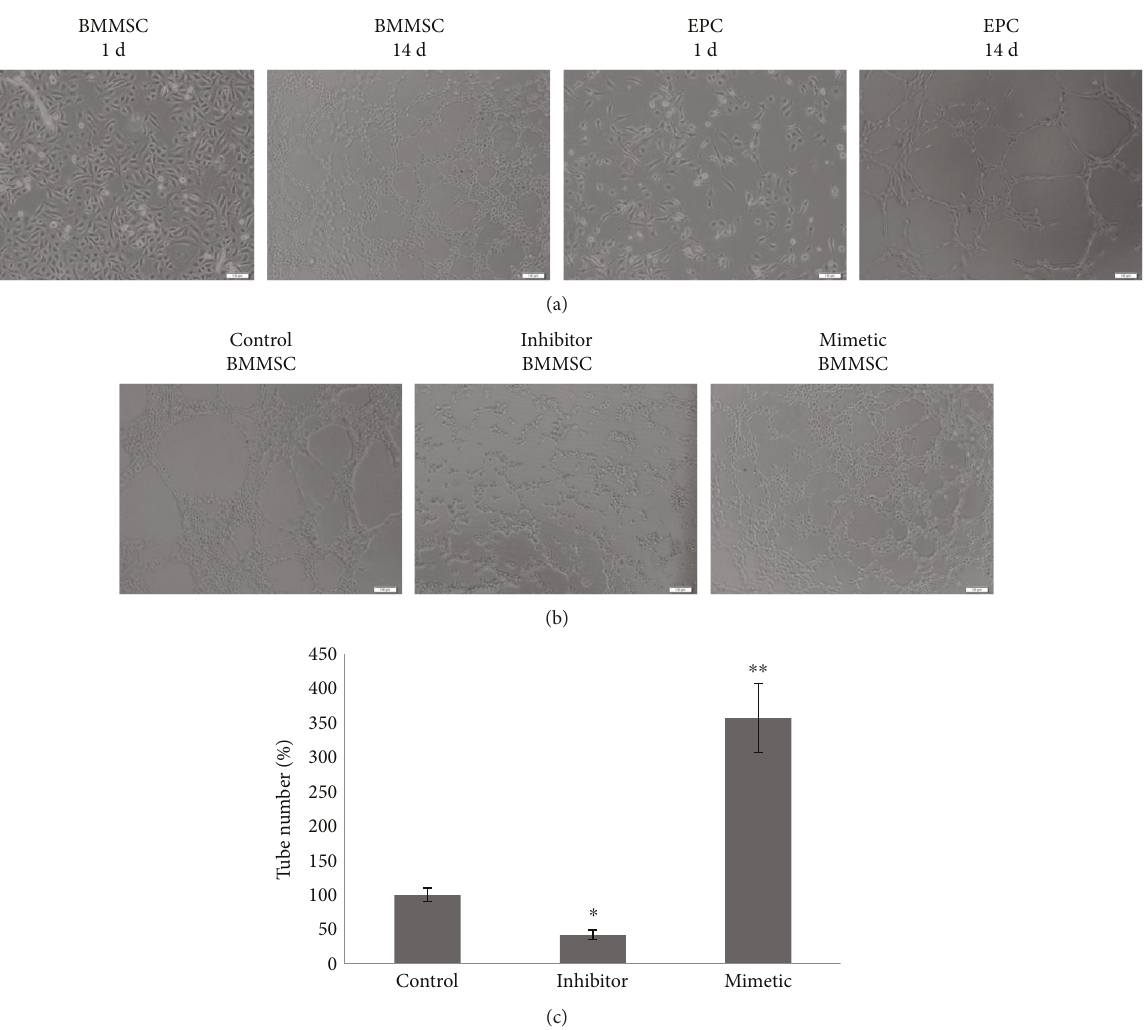
Figure 4: The e ff ects of miR-378 on capillary tube formation of HUVECs on Matrigel. (a) E ff ects of capillary tube formation of HUVECs and EPC on Matrigel. (b) E ff ects of miR-378 on capillary tube formation of HUVECs on Matrigel. BMMSC that transfected with miR-378 mimetic, miR-378 inhibitor, and negative controls. After 14 days of incubation, the numbers of capillary tubes formed were counted (c). The experiment was repeated twice with comparable results. The untreated cells (control) were assigned to values of 100 and the results were presented as mean ± S.D. ( n = 3 ). Signi fi cance: ∗ P < 0 05 and ∗∗ P < 0 01 versus control